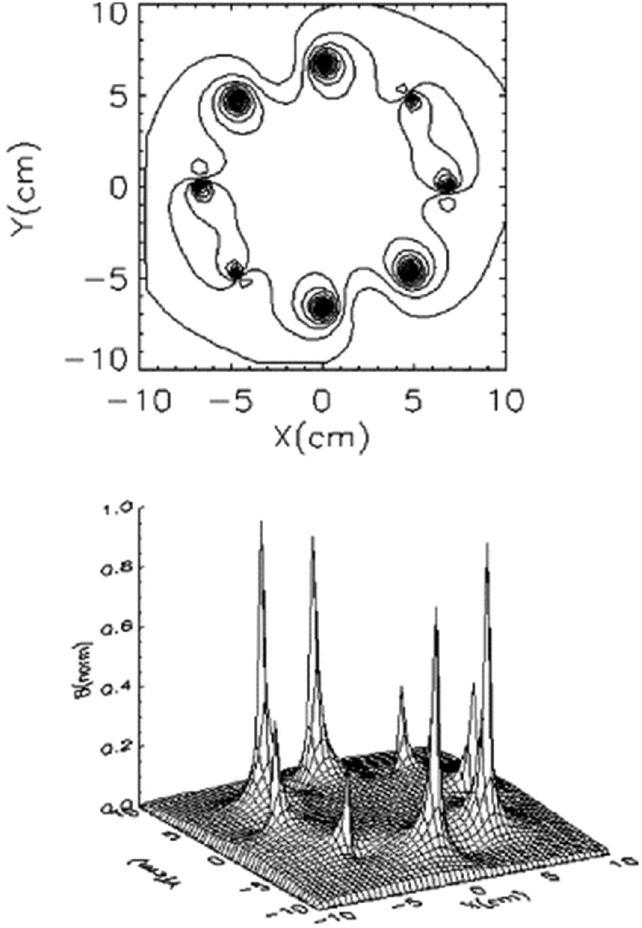
Figure 3. B 1 field contour and three-dimensional plots of an eight-leg low-pass birdcage coil for mode 1. Reprinted from [34].